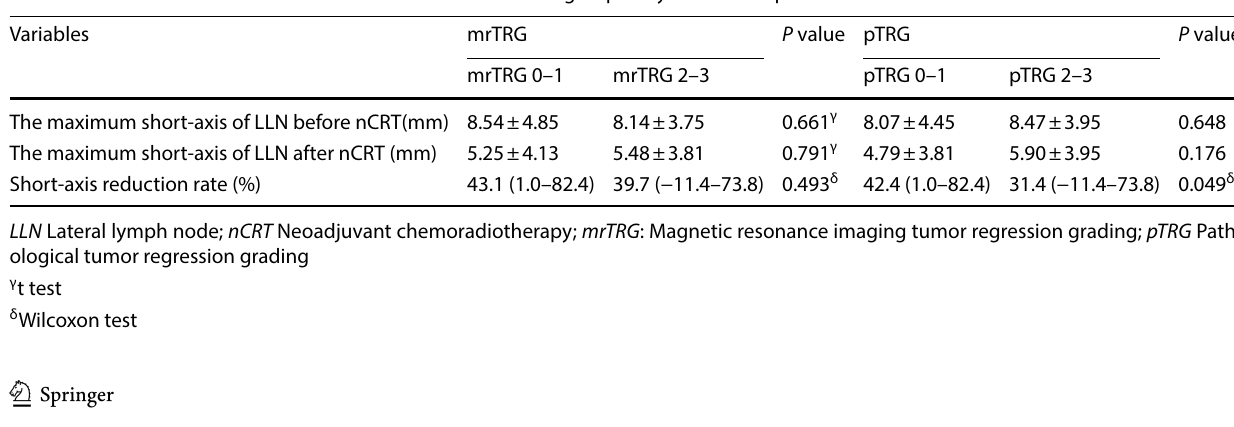
Table 5 The maximum short-axis of LLN before and after nCRT grouped by mrTRG and pTRG